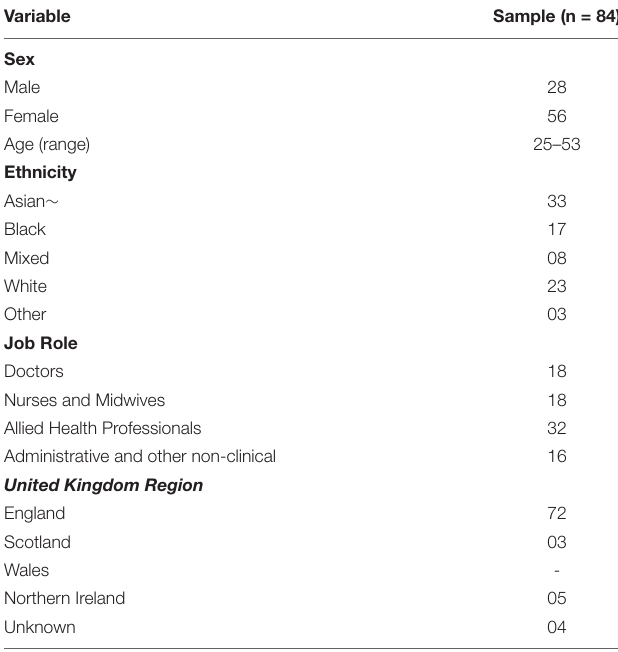
TABLE 1 | Participants’ demographic